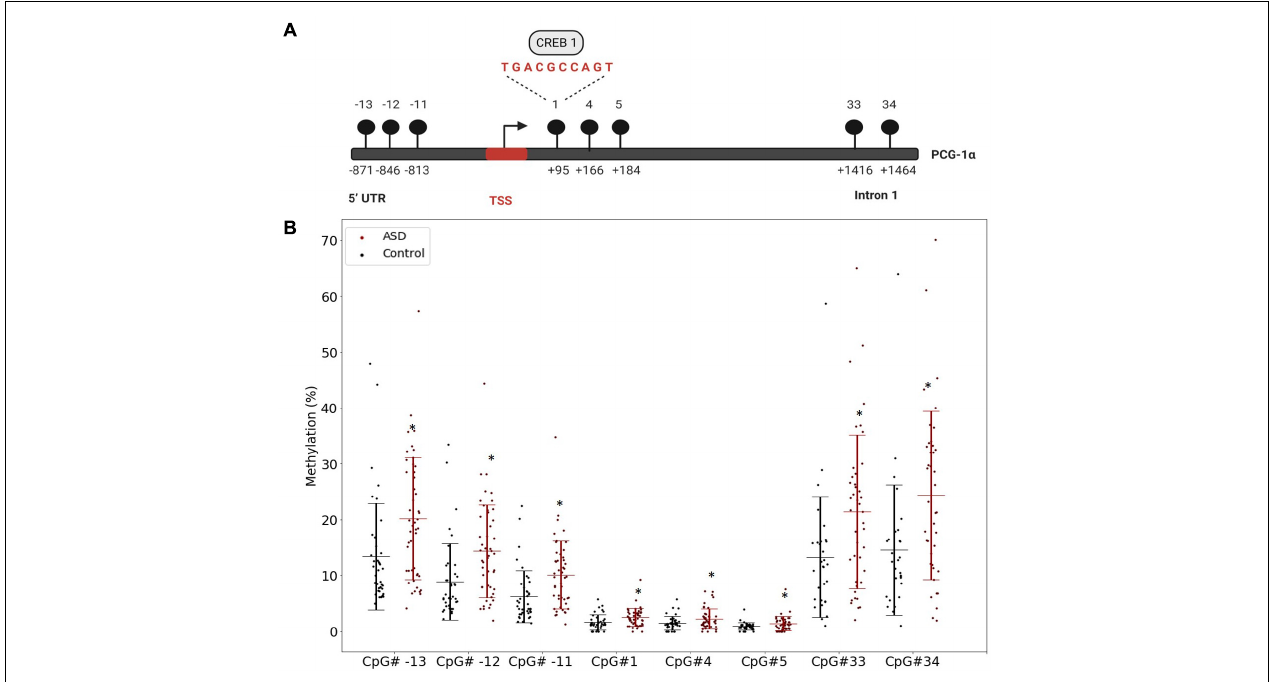
FIGURE 1 | The PGC-1 α promoter is hypermethylated in autism spectrum disorder (ASD). (A) Diagrammatic representation of the PCG-1 α gene promoter region (Chr4:23889974) showing the location of the eight hypermethylated CpG sites (black circles) relative to the transcription start site (TSS) and the sequence of the binding site for the transcription factor, CREB1. (B) Percentage methylation of the eight differentially methylated PGC-1 α promoter CpG sites measured using Targeted Next-Generation Bisulfite Sequencing (ASD n = 55, controls n = 44) (UTR = untranslated region). Differential methylation was identified using a two-tailed unpaired t -test with unequal variance ( p < 0.05). Data represent the percent methylation in each individual at each site; box plots represent the mean percent methylation in either controls (black) or ASD (red) at each site; error bars represent standard deviations.